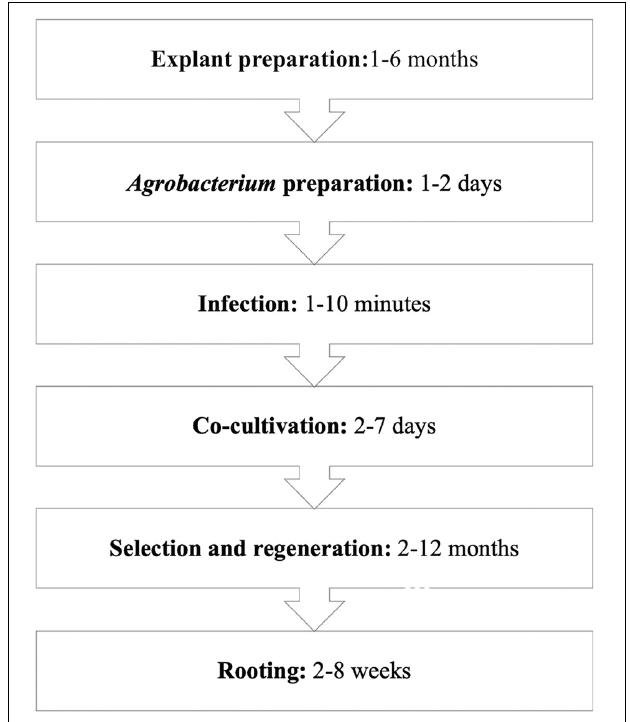
FIGURE 2 | General protocols for Agrobacterium tumefaciens -mediated transformation of F&N crops (e.g., blueberry) (Song, 2015).